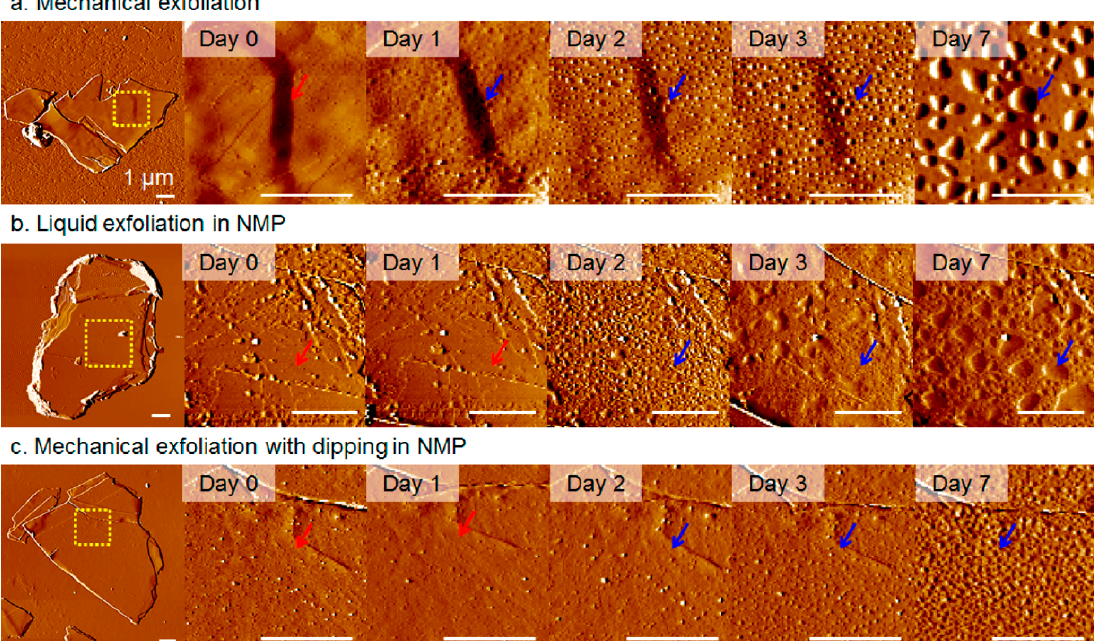
Figure 17. AFM amplitude images (amplitude scale: 5 × 5 nm (top left), 1 × 1 nm (magnified images)) of BP flakes prepared by ( a ) mechanical exfoliation, ( b ) solvent exfoliation in N-methyl-2-pyrrolidone (NMP), and ( c ) mechanical exfoliation followed by 1 h submersion in NMP. The leftmost image shows the entire flake, and the images progressing to the right show magnified views immediately after exfoliation up to 7 days in ambient conditions. Structural deformations (i.e., apparent bubbles) are observable on the mechanically exfoliated sample after 1 day and on the rest of the samples after 2 days. Red and blue arrows indicate the same position on the BP flake before and after the appearance of bubbles, respectively. All flakes are thicker than 150 nm, and all scale bars are 1 µ m. Reproduced